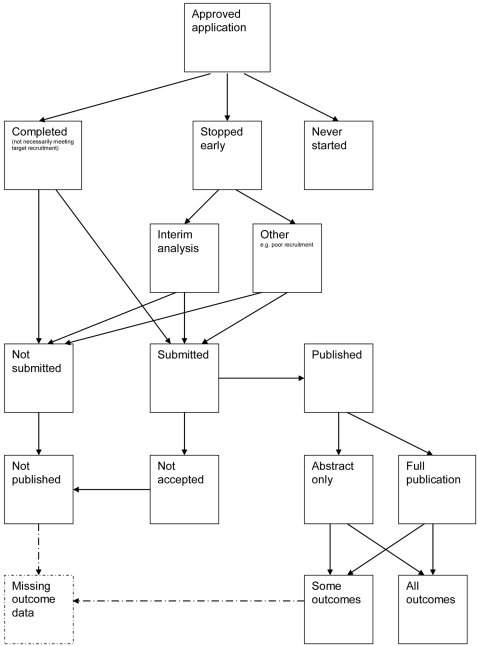
Study flow diagram.